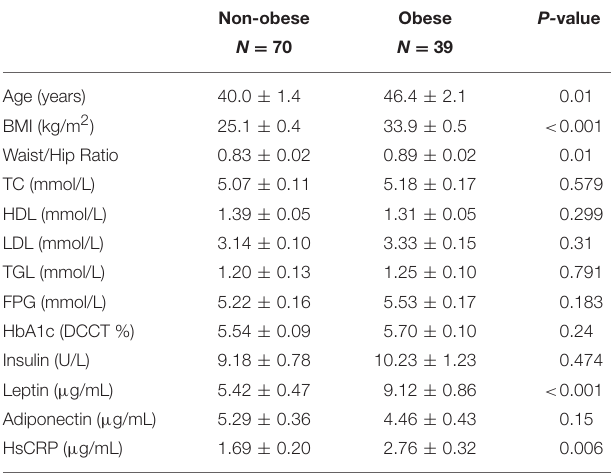
TABLE 2 | Demographics and characteristics of subjects without T2D.